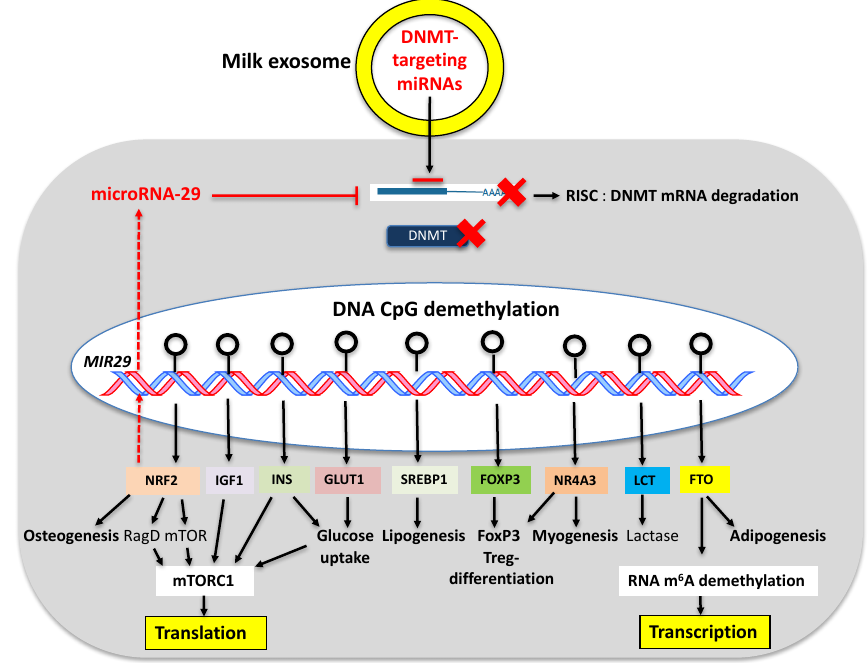
Figure 2. Working model of milk-mediated epigenetic regulation. Milk exosome-derived DNMT-targeting miRNAs enhance DNA promoter demethylation of critical CpG islets involved in the upregulation of gene expression of pivotal transcription factors (NRF2, SREBP1, FOXP3, NR4A3) and key metabolic regulators (INS, IGF1, CAV1, GLUT1, LCT) and the RNA m 6 A demethylase FTO. Milk-derived DNMT-targeting miRNAs may thus play a fundamental role in epigenetic enhancement of transcription and translation (see list of